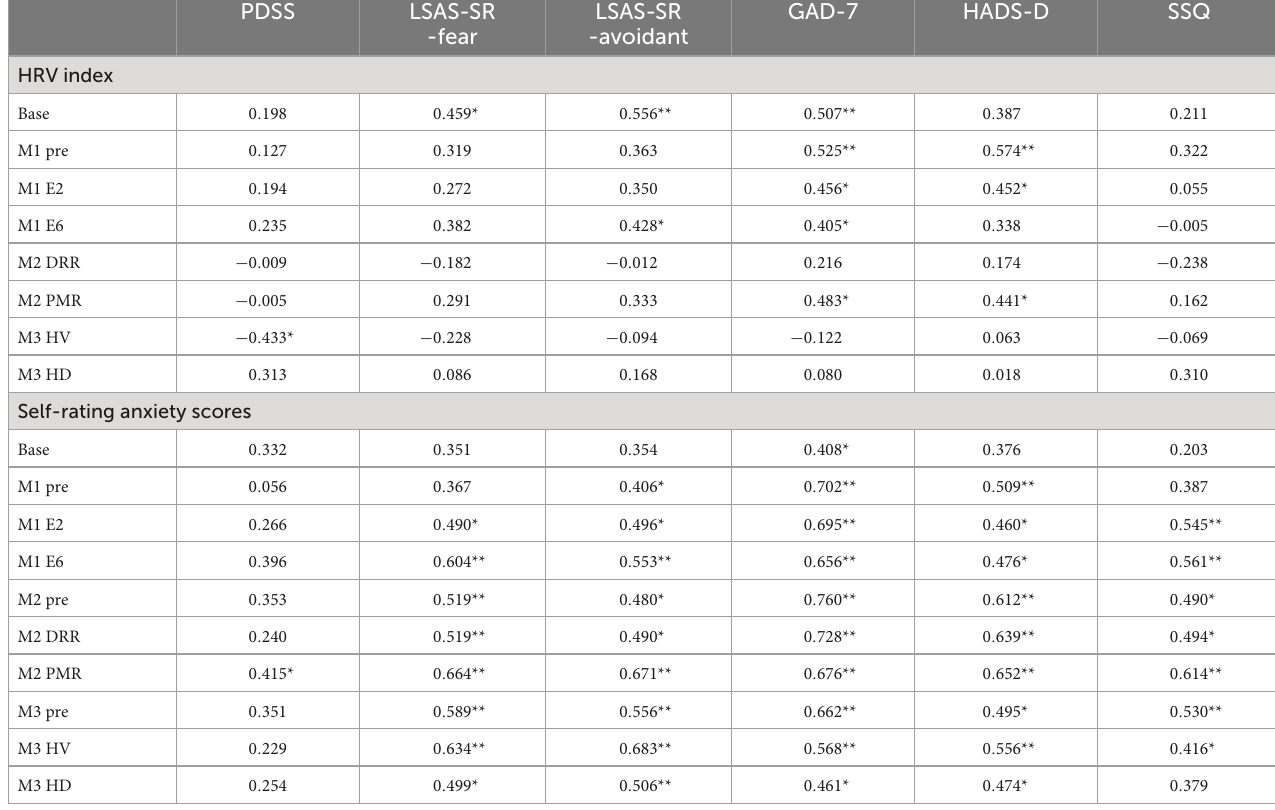
TABLE 5 Correlations among variables in virtual reality-based assessment in panic disorder (VRA-PD), psychological characteristics and simulator sickness questionnaire (SSQ) in the ANX group. PDSS LSAS-SR LSAS-SR GAD-7 HADS-D -fear -avoidant